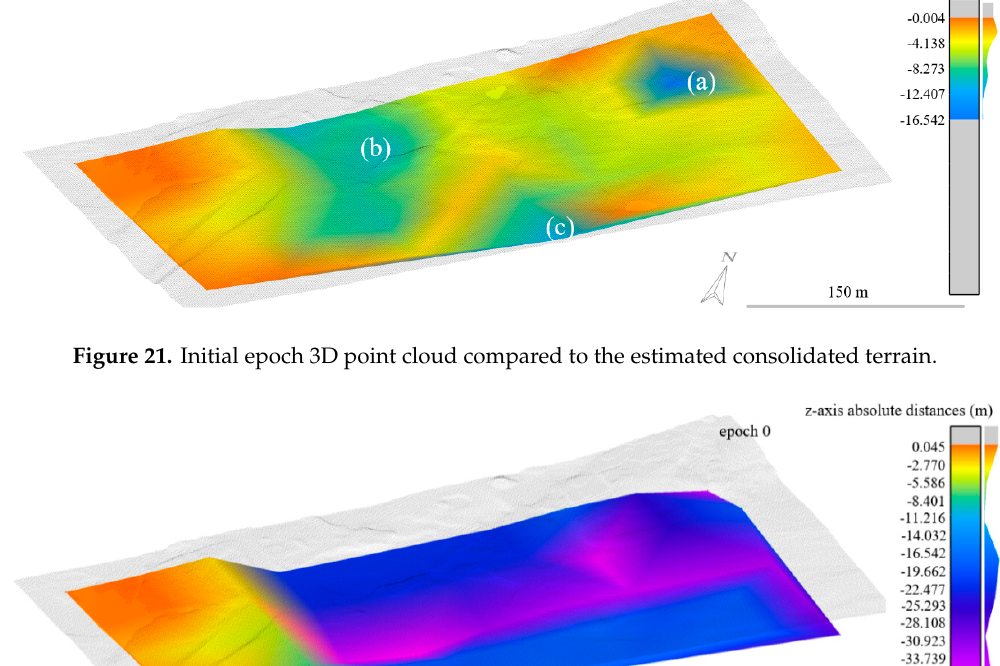
Figure 21. Initial epoch 3D point cloud compared to the estimated consolidated terrain.